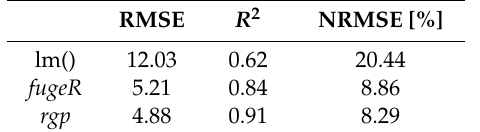
Table 2. Summary of FPF prediction performance for models created with different methods.